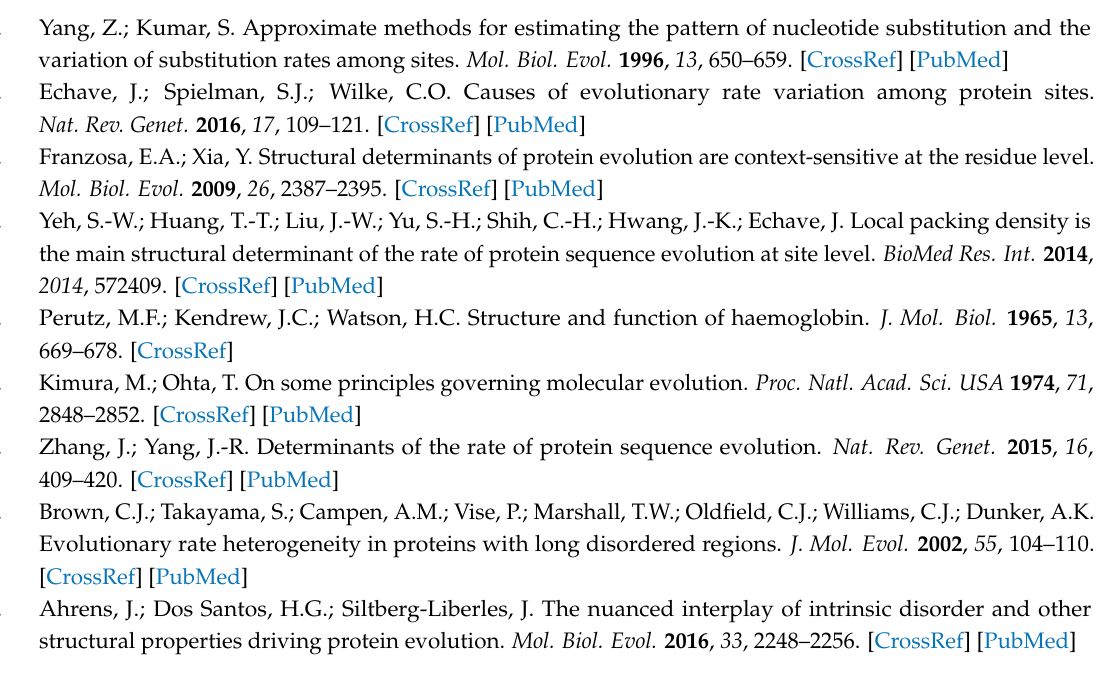
s1, Figure S1: Dataset information, Table S1: GO Term results, Table S2: Nonparametric Post-Hoc Multiple Comparison